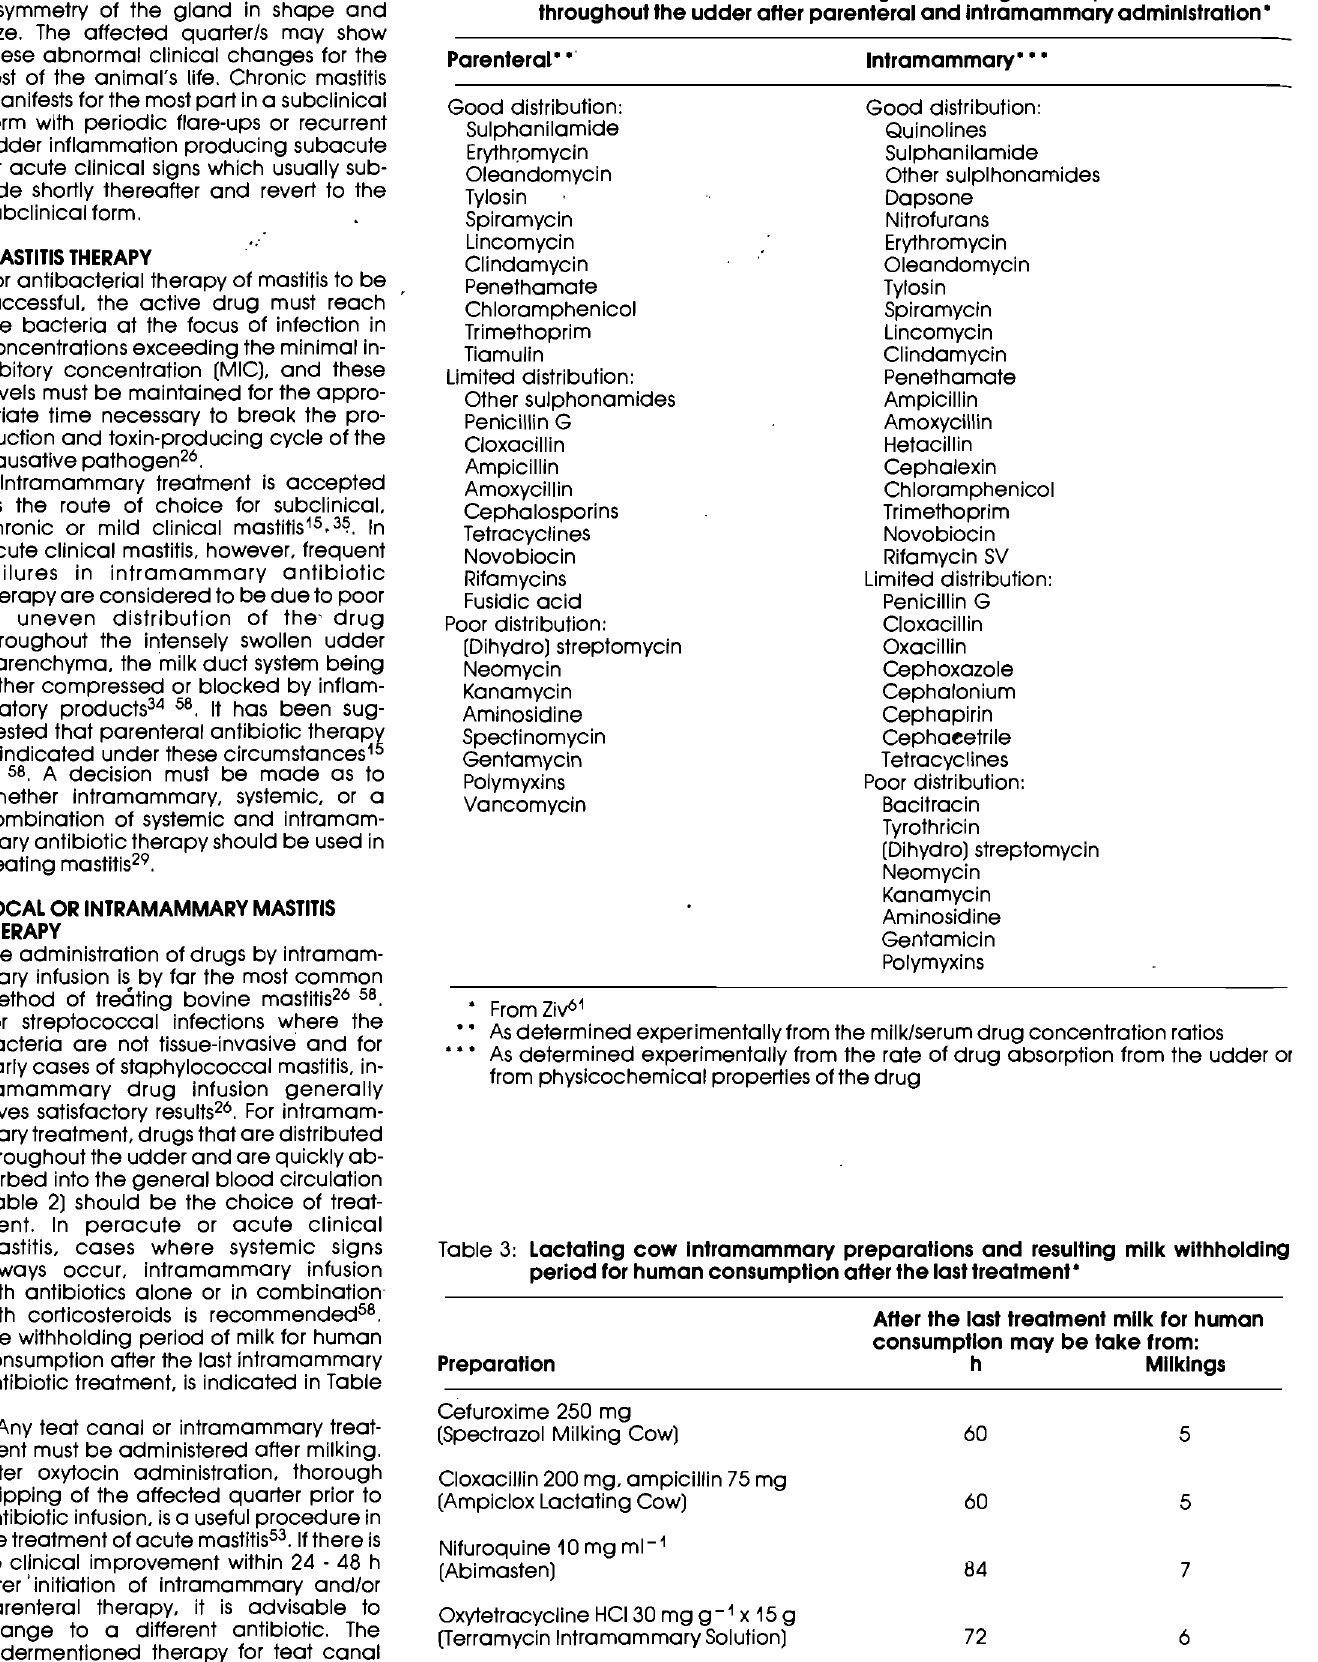
Table 3: Lactating cow Intramammary preparations and resulting milk withholding period for human consumption aHer the last treatment·